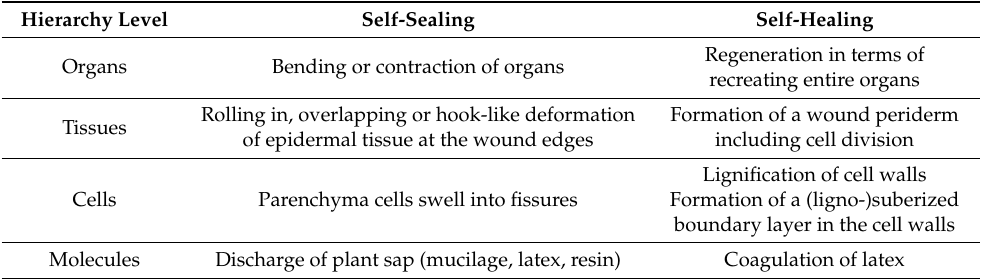
Table 2. Overview of common self-repair mechanisms found in vascular plants arranged according to increasingly smaller hierarchy